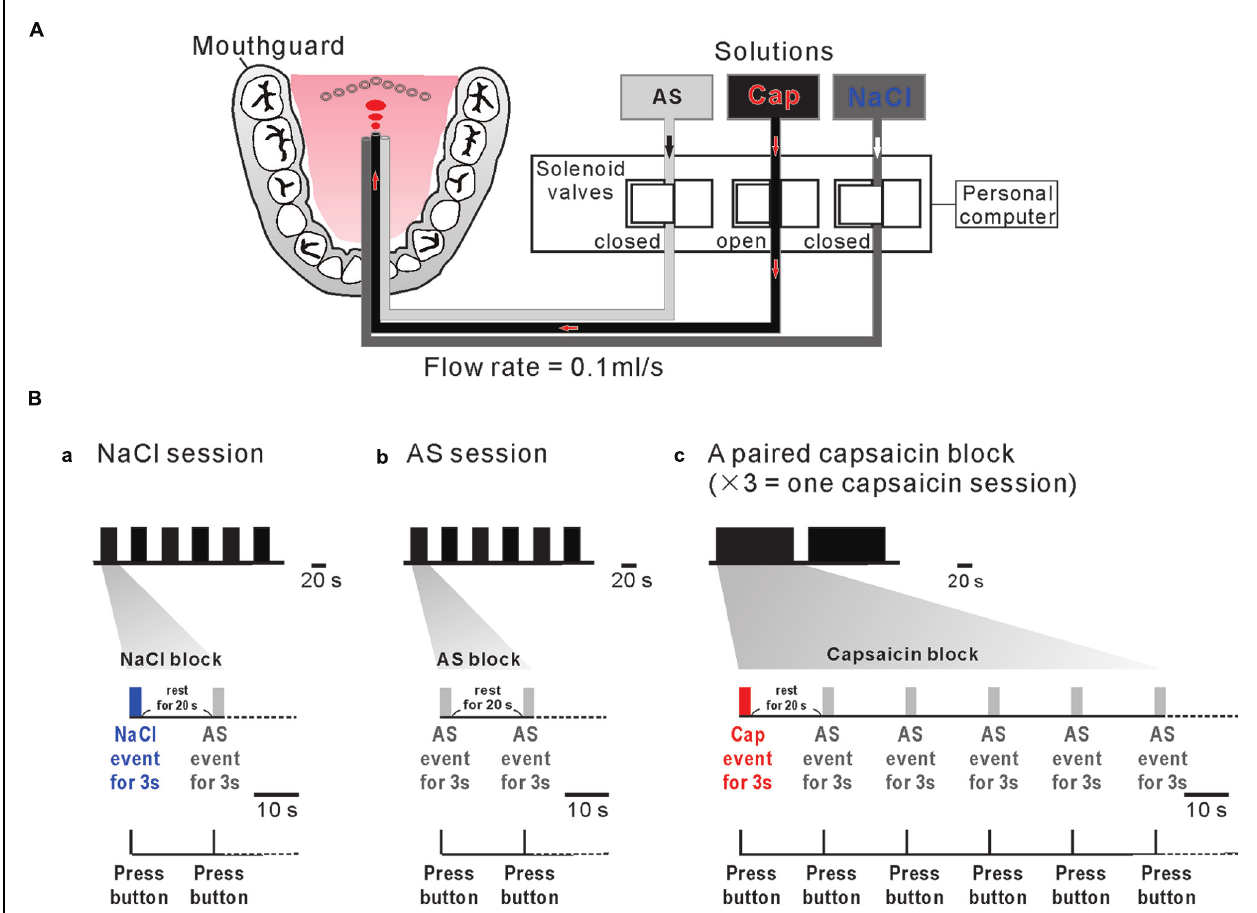
FIGURE 1 | A custom designed taste delivery system and experimental design. (A) A schematic diagram of tastants delivery system. Tastants delivered through the three tygon tubes, the tastant flow through which was regulated by the respective solenoid valves that are controlled by a personal computer. Three solutions; artificial saliva (AS), capsaicin (Cap), and NaCl were administered at 0.1 ml/s constant flow rate. (Ba–c) NaCl event for 3 s (blue bar) followed by AS event for 3 s (gray bar) with an interevent interval of 20 s was applied six times every 20 s (one NaCl session) (a) . AS event for 3 s (gray bar) followed by AS event for 3 s (gray bar) with an interevent interval of 20 s was applied six times every 20 s (one AS session) (b) . Capsaicin event (red bar) for 3 s followed by five 3 s AS events (gray bar) applied every 20 s was repeated two times with an interval of 138 s. A paired capsaicin block (c) which contains two capsaicin events was repeated 3 times every 10 min (one capsaicin session). Subjects pressed the button as soon as they felt a liquid on their tongue